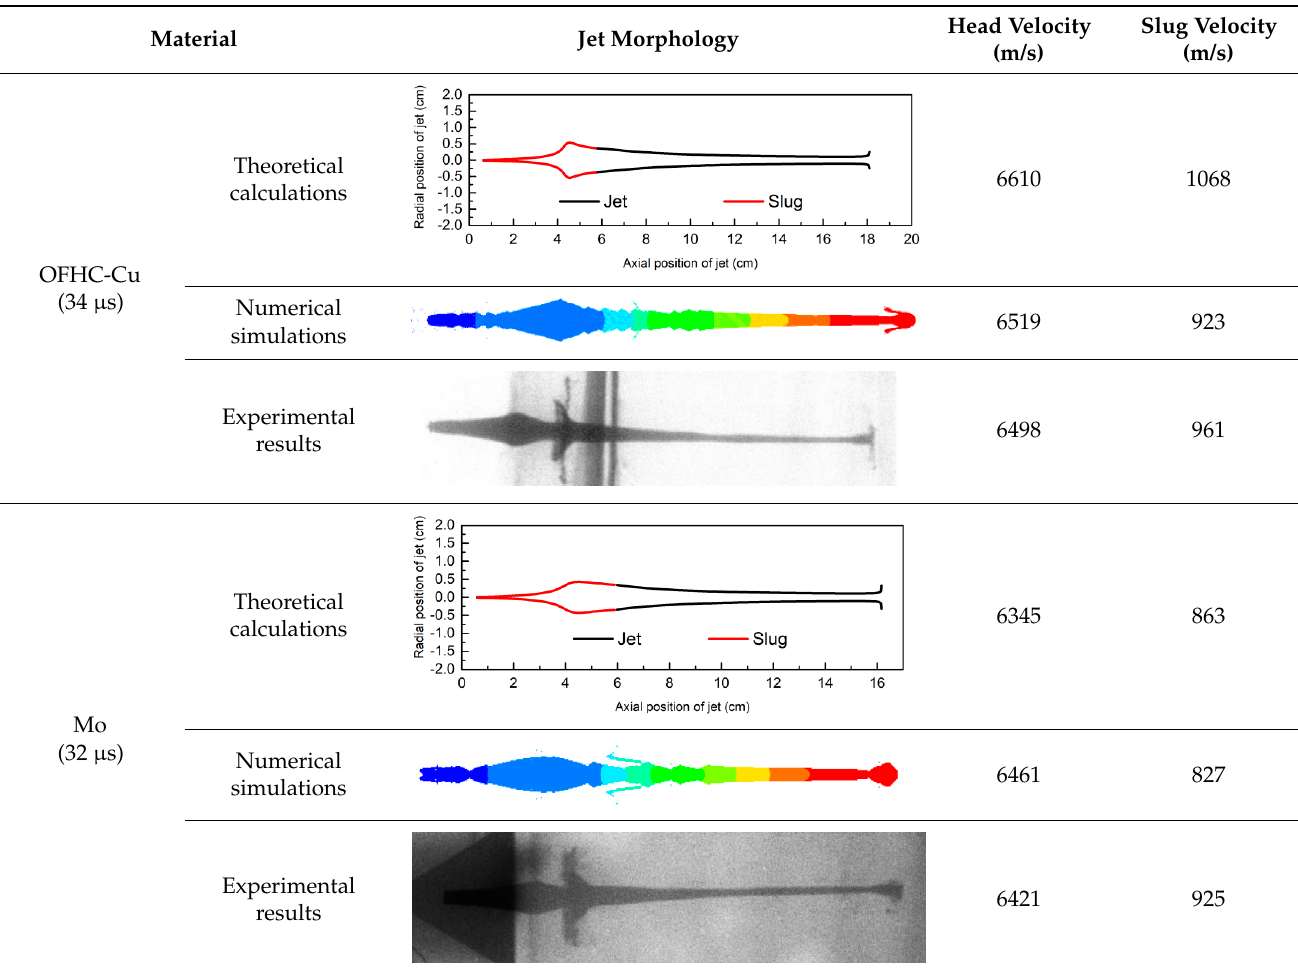
7 of 17 Figure 5. Computational simulation model. Table 1. Main material parameters of the numerical model. JH-2 [27]